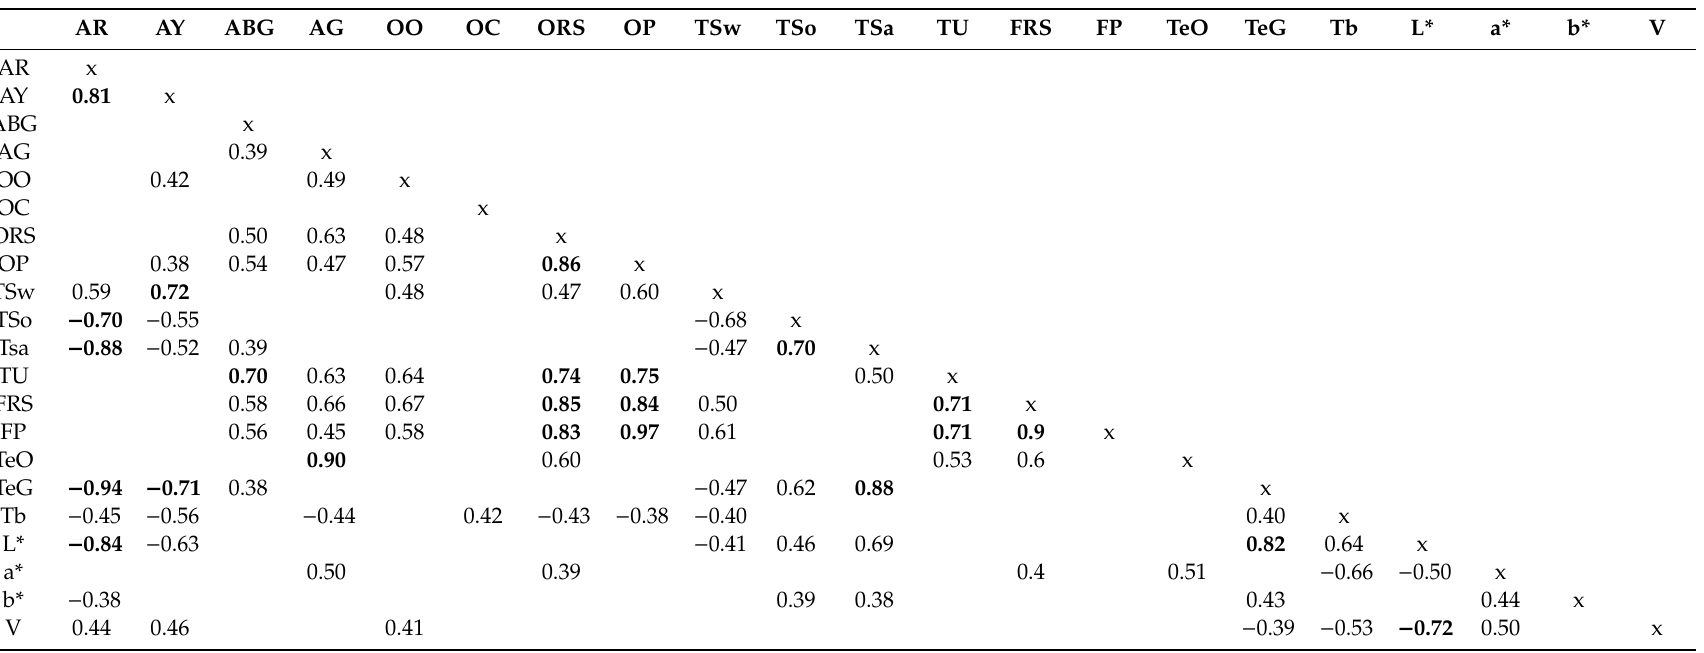
Table 6. Significant Pearson correlations between measurements, bold text = | 0.7 | or larger. Bold text = significant and | 0.7 | or